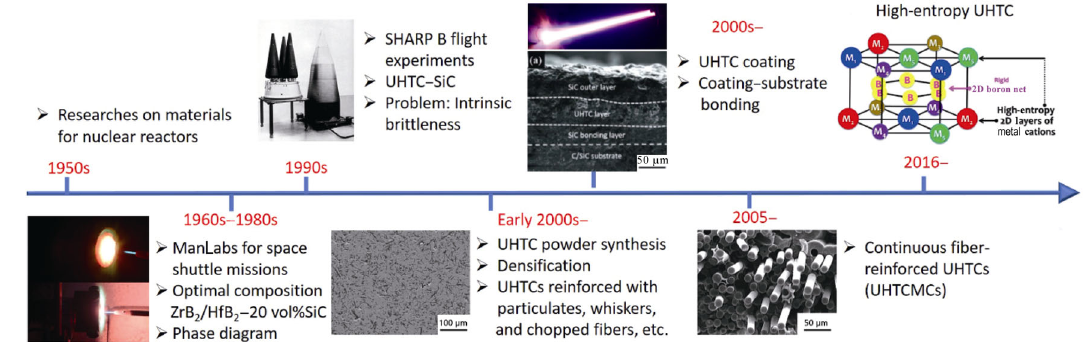
Fig. 1 Historical perspective on research related to ultra-high temperature ceramics and